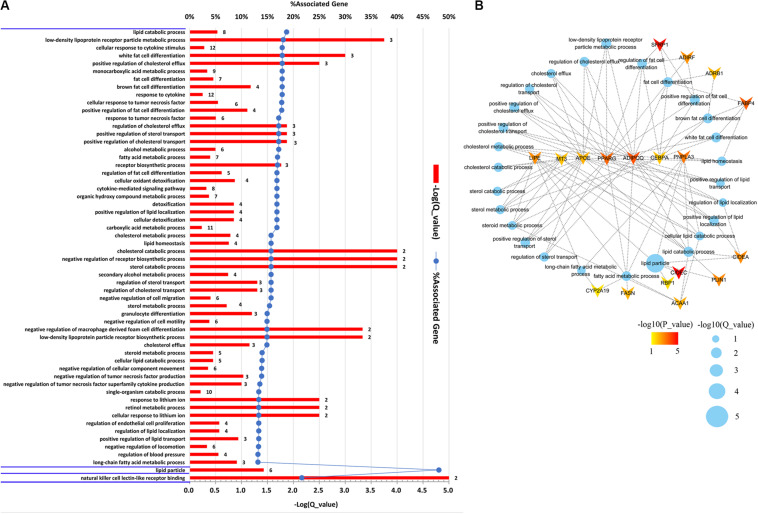
Gene Ontology (GO) enrichment analysis of differentially expressed genes (DEGs). (A) Significantly enriched GO terms of the DEGs detected by DEseq2 and edgeR with |log2(fold change)| ≥ 1 and p < 0.05. The figure is composed of three parts, biological processes, cellular components, and molecular functions, which are divided by blue horizontal lines. The significance level of enrichment was set at corrected p-value (q-value) < 0.05. (B) Significantly enriched GO terms related to lipid metabolism and fat cell differentiation. Blue dots represent enriched GO terms. Genes involved in GO terms are represented by V shape. The colors of genes are decided by the p-values examined by DEseq2.